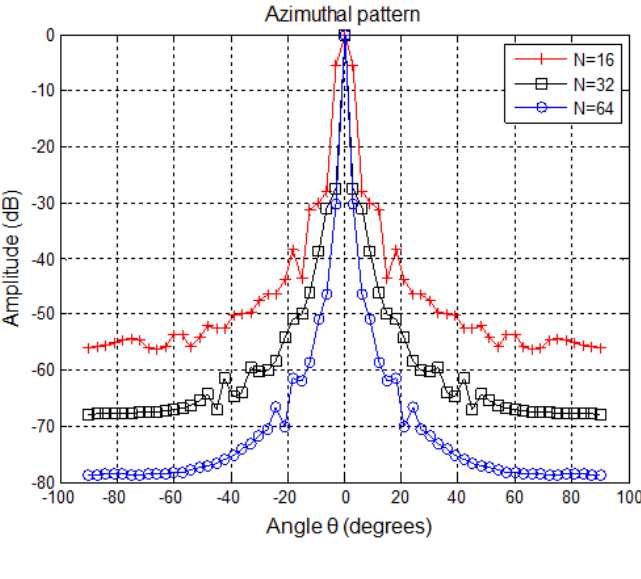
Figure 3. Variation of the azimuth pattern according to the number N of